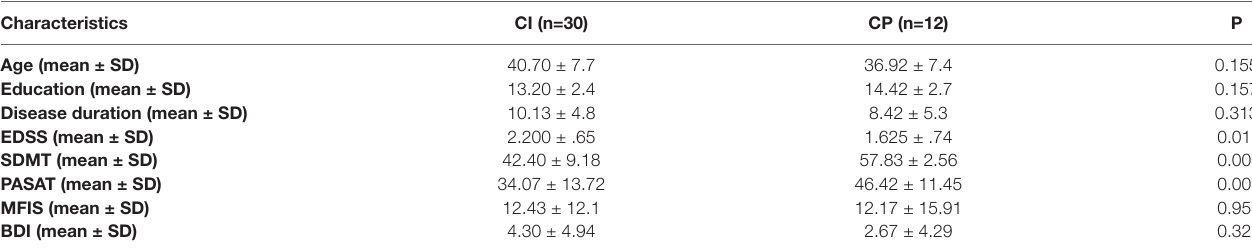
CI, cognitively impaired; CP, cognitively preserved; EDSS, Expanded Disability Status Scale; SDMT, Symbol Digit Modalities Test; PASAT, Paced Serial Addition Test; MFIS, Modified Fatigue Impact Scale; BDI, Beck Depression